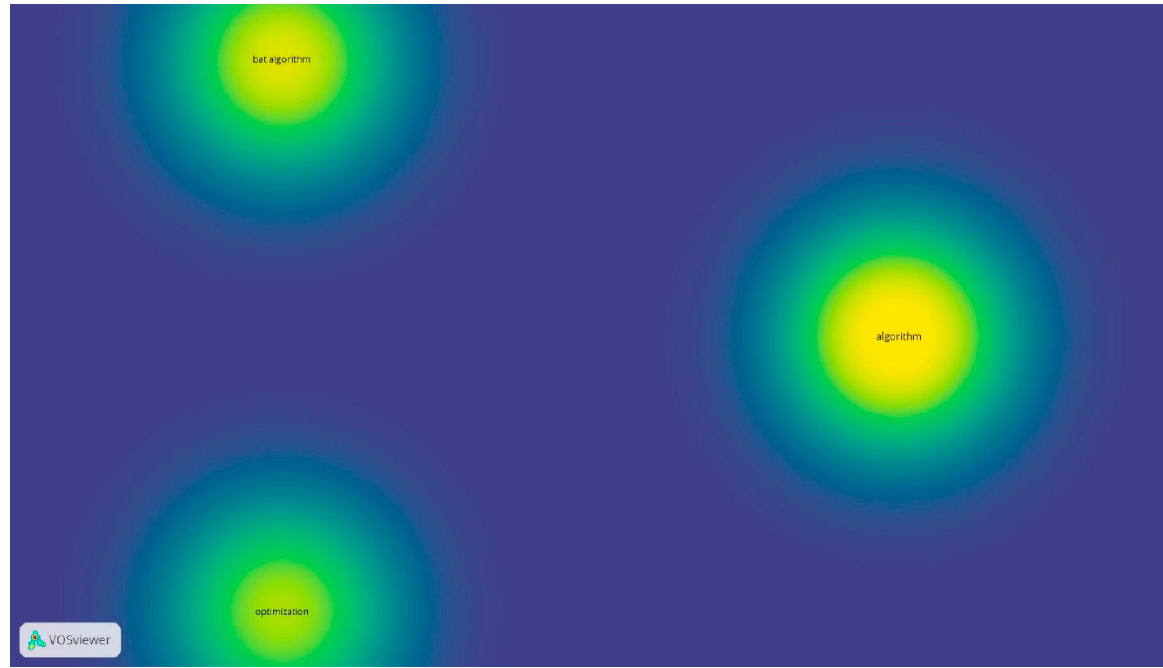
Figure 16. Total cluster obtained with the search “optimization fuzzy clustering with bat algorithm” from VOSviewer.